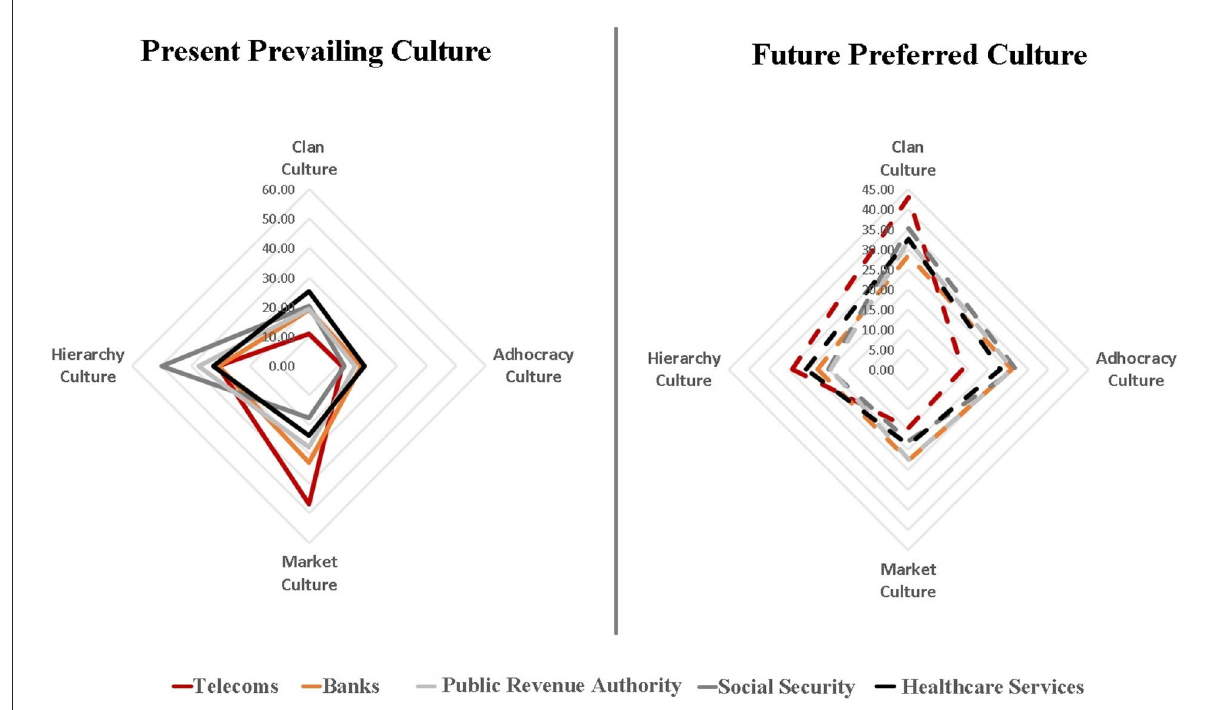
FIGURE2 Current and desired organizational culture in five sectors of the Greek economy. Lampos, 2016; Gkila, 2017; Vassilakopoulou, 2017; Tsegkou, 2018; Zervea et al., 2021, processed by